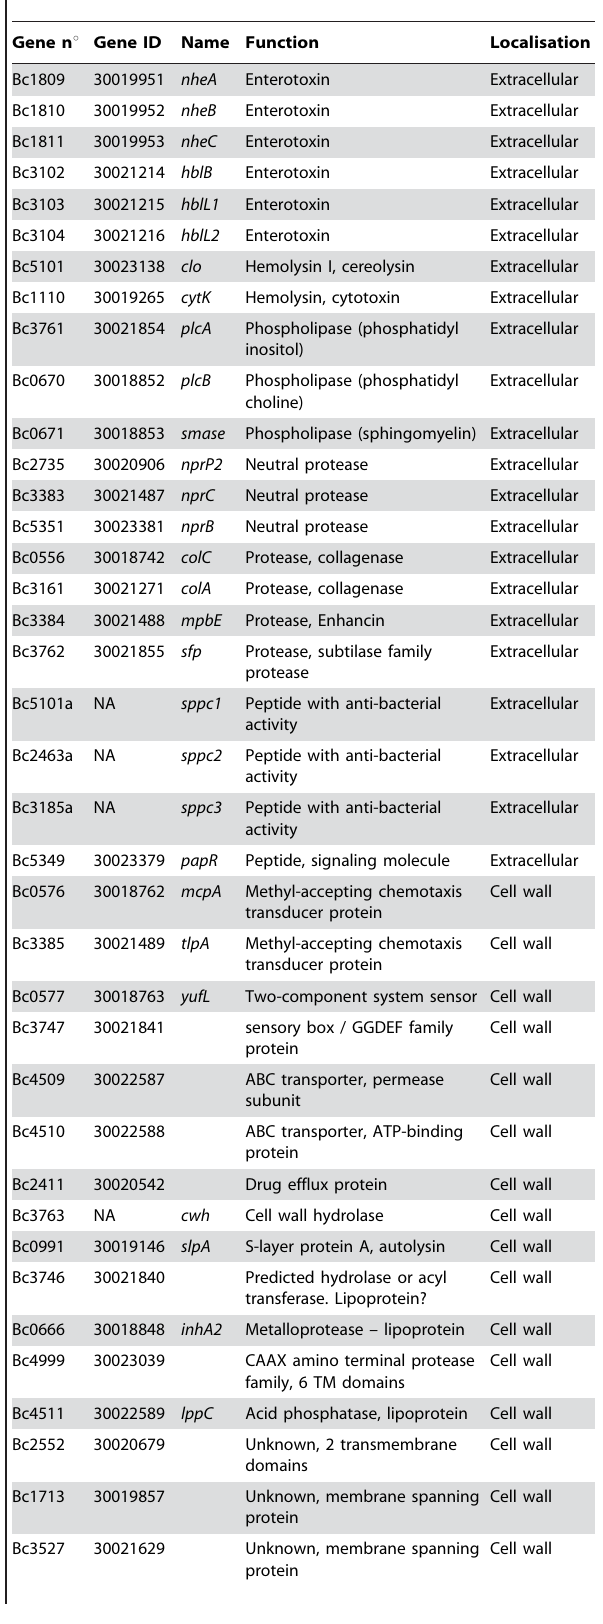
Table 2. List of the PlcR-controlled genes in the ATCC14579